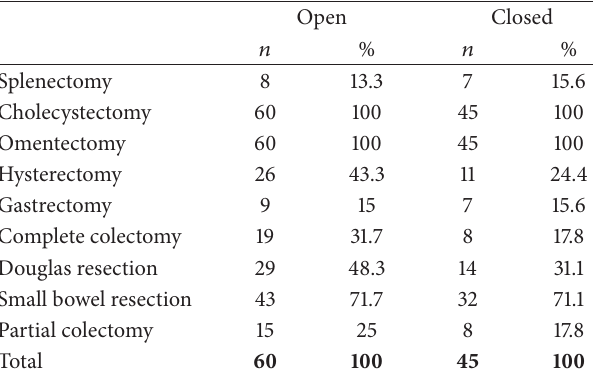
Table 2: Operations